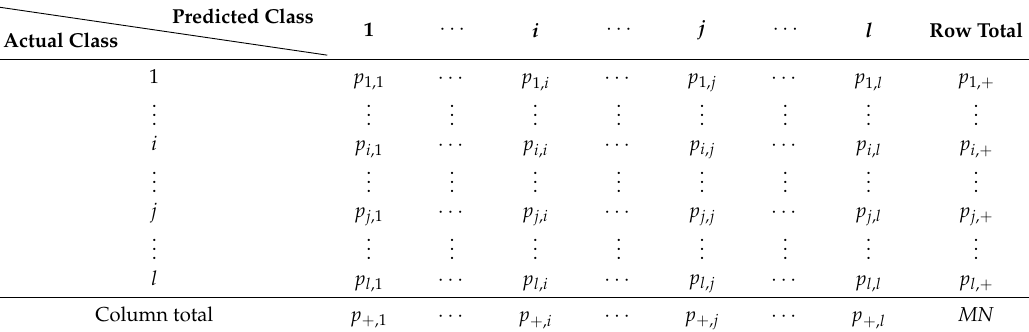
Table 1. Confusion matrix of an algorithm.